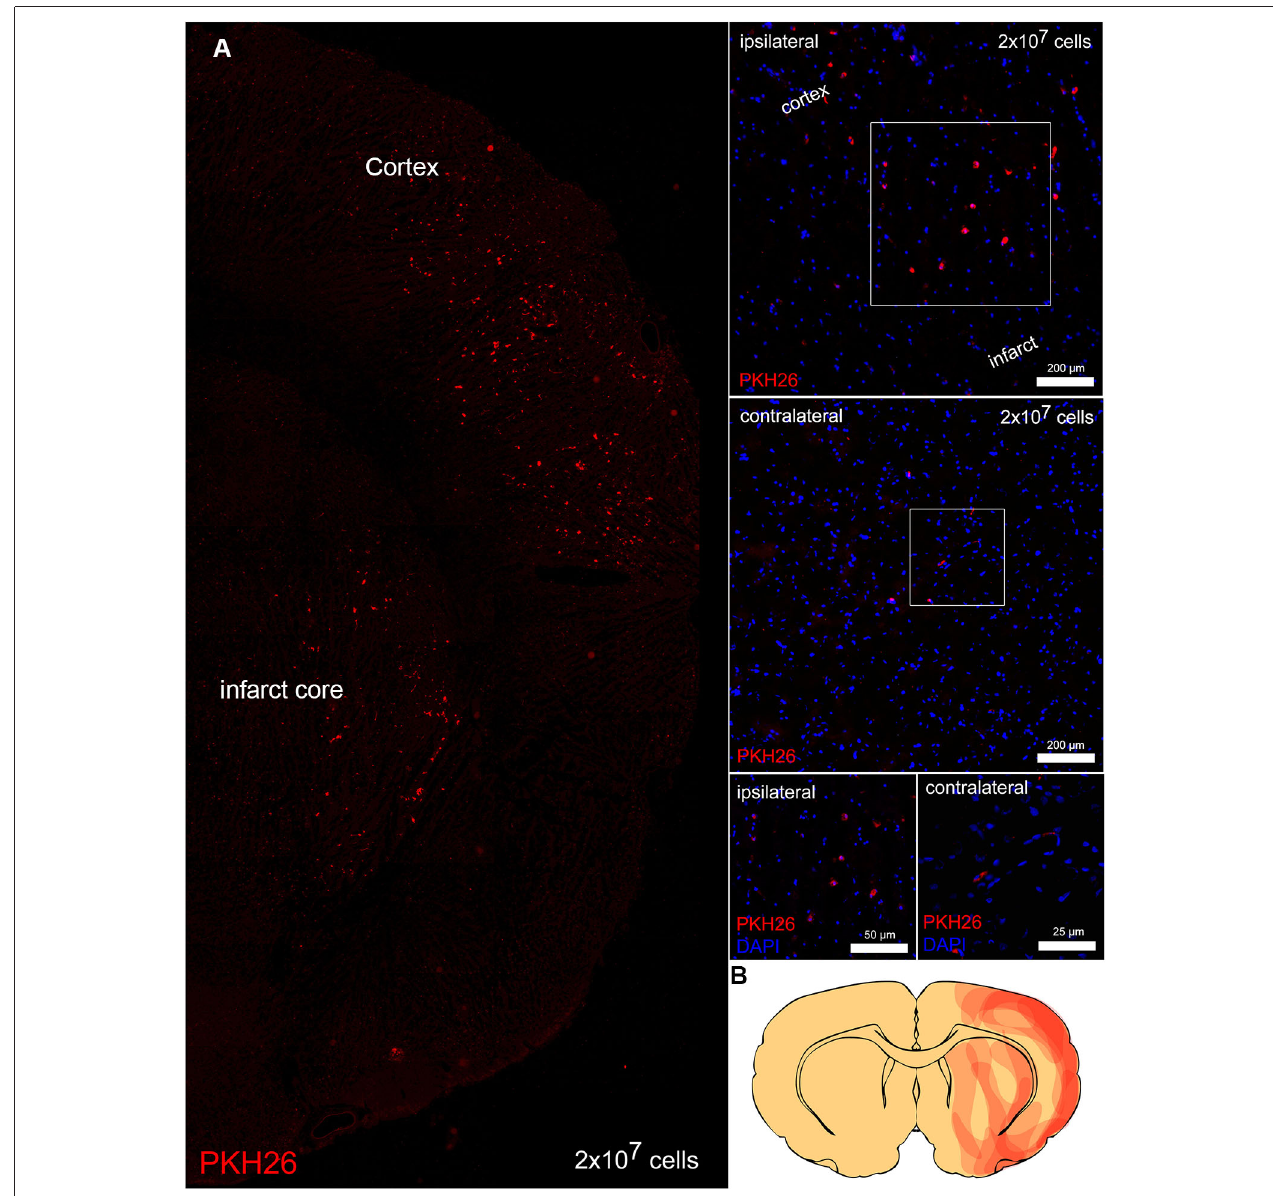
a few PKH26 positive cells were detected contralateral. Nuclei were counterstained with 4 (cid:48) , 6-diamidino-2-phenylindole (DAPI, blue). (B) The map depicts immigrated PKH26 positive cells within the infarcted hemisphere (obtained from five